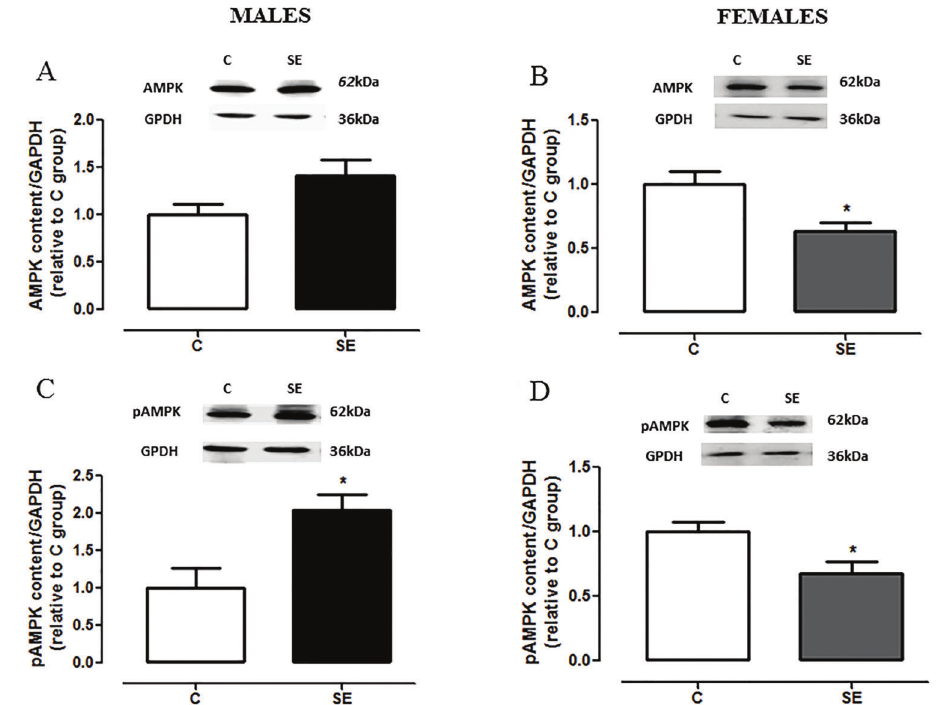
Figure 7. Long-term effects of neonatal cigarette smoke exposure on AMPK and pAMPK in the hypothalamus. AMPK ( A and B ) and pAMPK ( C and D ) protein contents in the ventromedial nucleus of the hypothalamus at 180 postnatal days in males and females. Representative blots of proteins are shown above the graphs. GAPDH content was used as loading control. Data are reported as relative % to the control group. C: control group; SE: smoke-exposed group. Results are reported as means ± SE for n=6 – 8. *P o 0.05 ( t